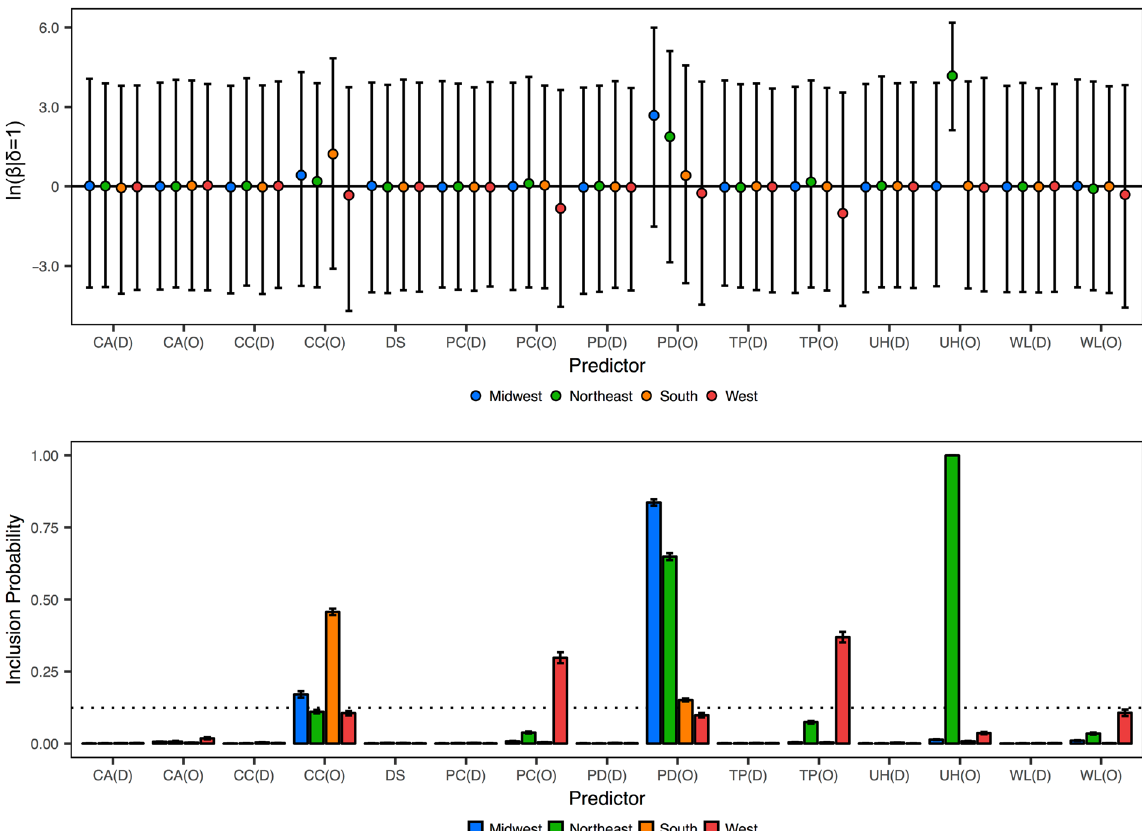
Figure 2. Posterior metrics for the predictors in the four county-level regional models. Inclusion probabilities for the predictor indicators ( δ ) and corresponding regression coefficients ( β ) for the 15 predictors for Midwest, Northeast, South, and West models. The dotted line corresponds to BF = 3. Error bars represent the standard error for each predictor’s inclusion probability and the 95% HPD for each predictor’s regression coefficient. Predictors are annotated with their evaluation from location of origin (O) and location of destination